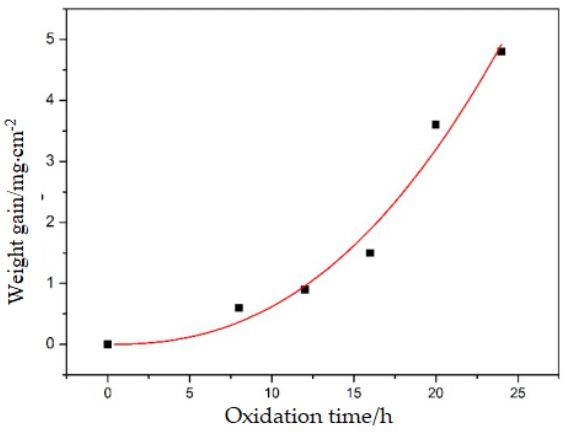
Figure 12. Weight gain curves of Ni / ZrO 2 coating.